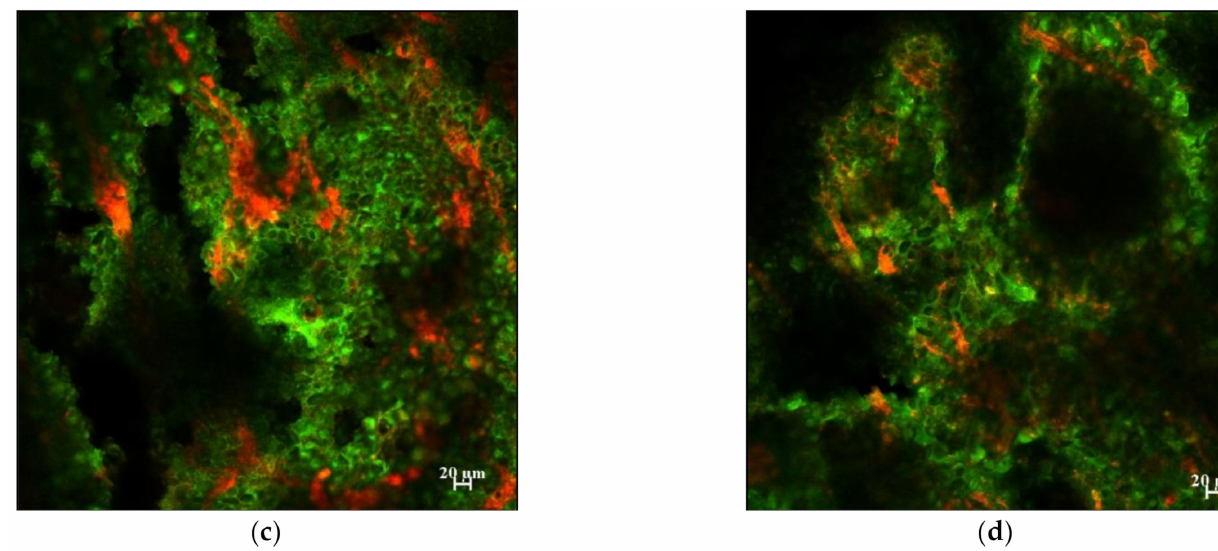
Figure 7. Confocal microscopy images of the crackers with ( a ) 0.1%, ( b ) 1.0%, ( c ) 8.1%, and ( d ) 20.0% fat content. Proteins are stained with Rhodamine B (seen in red), and lipid phases are stained with BODIPY (seen in